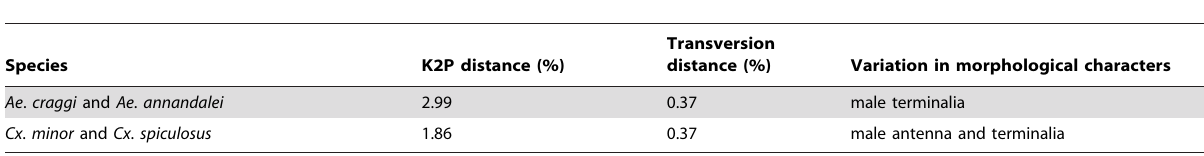
Table 3. Interspecific K2P distance, transversion distance, and morphological characters of some mosquitoes.